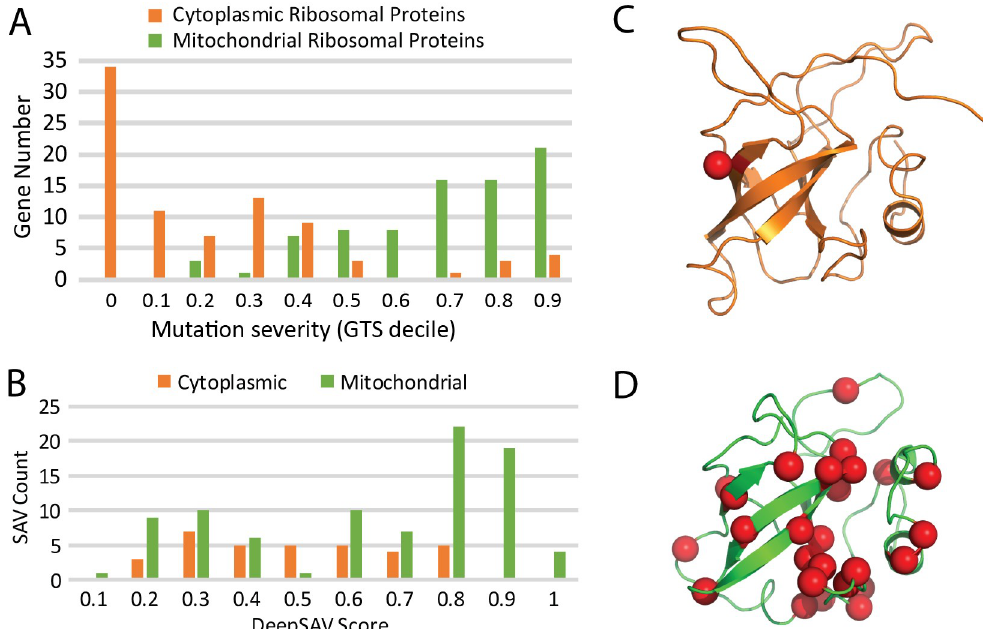
Fig 6. A) Mutation severity spectrum of ribosomal proteins functioning in the cytoplasm (orange bars) and in the mitochondria (green bars) measured by their numbers in GTS deciles. B). DeepSAV score distribution for 34 gnomAD SAVs of cytoplasmic ribosomal protein RPL23 (orange) and 89 gnomAD SAVs of mitochondrial ribosomal protein MRPL14. C) 60S ribosomal protein RPL23 from cytoplasm (PDB: 6ek0, chain LV) in orange cartoon has a single detrimental predicted SAV (red sphere). D ) Mitochondrial 39S ribosomal protein MRPL14 (PDB 5oom, chain L) in green cartoon has multiple predicted detrimental SAVs. The mutation-tolerance observed for nucleus-encoded mitochondrial proteins might reflect their roles in metabolic processes [85]. However, this tendency is also exhibited by the ribo- somal proteins that function in mitochondria compared to ribosomal proteins functioning in cytoplasm (Fig 6A): the majority of mitochondrial ribosomal proteins have high GTS scores while the majority of cytoplasmic ribosomal proteins have low GTS scores. As an example, side- by-side comparison of ribosomal L14P/L23E-like proteins functioning in the cytoplasm (RPL23, Fig 6B and 6C) and the mitochondria (MRPL14, Fig 6B and 6D) highlights their differ- ent levels of mutation-intolerance. Both proteins adopt similar small 5-stranded meander barrel folds with relatively long loops that interact with RNA in the assembled ribosome. Cytoplasmic RPL23 and mitochondrial MRPL14 have 34 and 89 gnomAD SAVs respectively, and exhibit predicted pathogenic variant (I40F, DeepSAV score = 0.788, Fig 6C) (protein length: 140 amino 0.75, all but one are rare with MAF < 0.0001) covering 28 positions (Fig 6D) (protein length: 145 residues). Neither of these examples possess known pathogenic variants, and only the cyto-